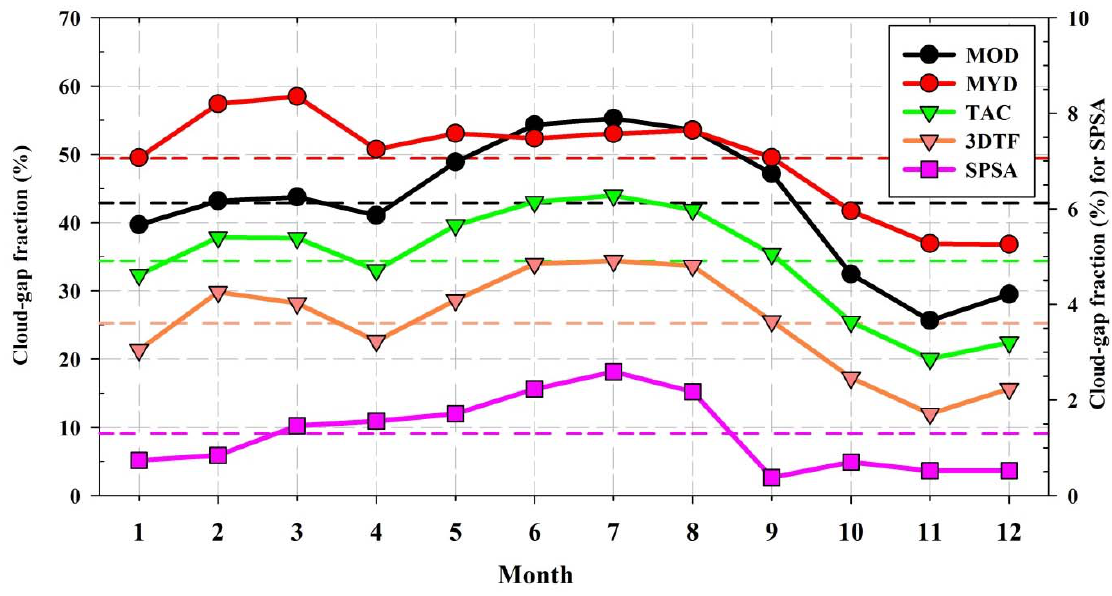
Figure 10. Mean cloud-gap fraction in di ff erent months after the execution of each gap-filling step. The cloud-gap fraction refers to the average fraction over the 16 years that were monitored. TAC: Terra and Aqua combination, 3DTF: Three-day temporal filtering, SPSA: Similar pixel selecting algorithm. The dashed horizontal line represents the average cloud-gap fraction.